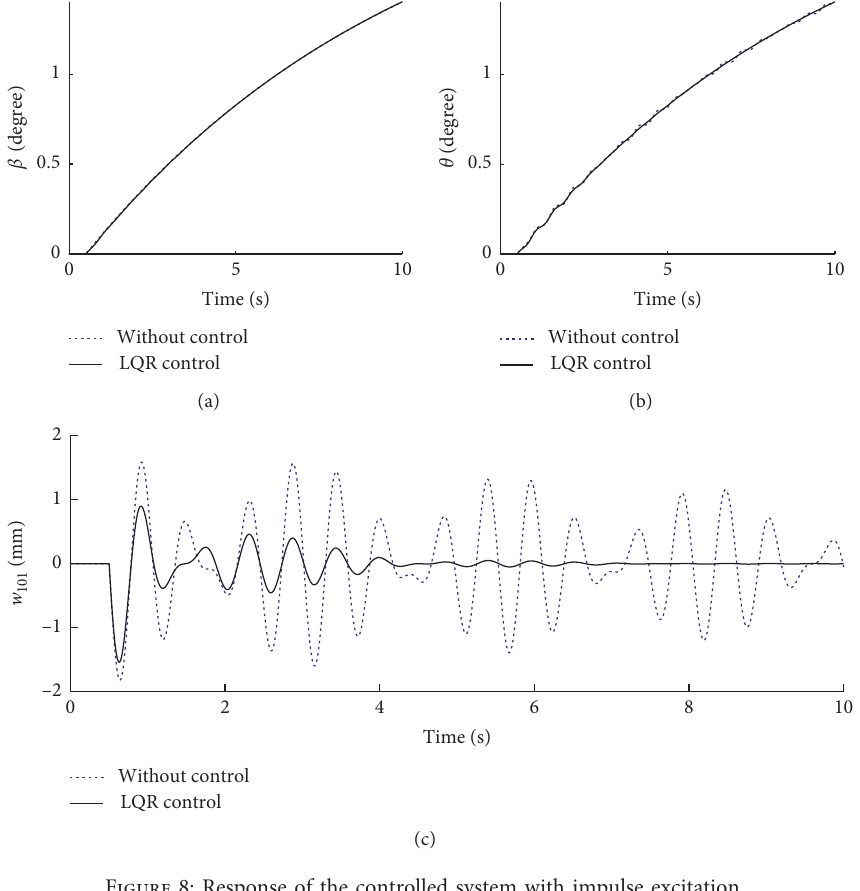
Figure 8: Response of the controlled system with impulse excitation.